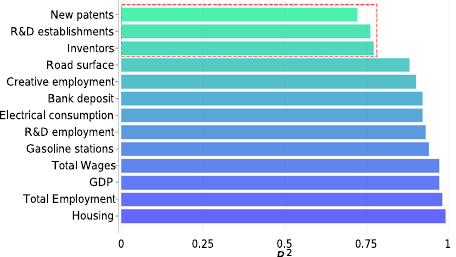
Fig. 1 Correlation coef fi cients between population size and various socio- economic outputs, adapted from Bettencourt et al. (2007a). Data suggest that innovation-related indicators (marked in red) are less correlated with population than other socio-economic outputs. These results are computed with data covering the [1997, 2003] period.